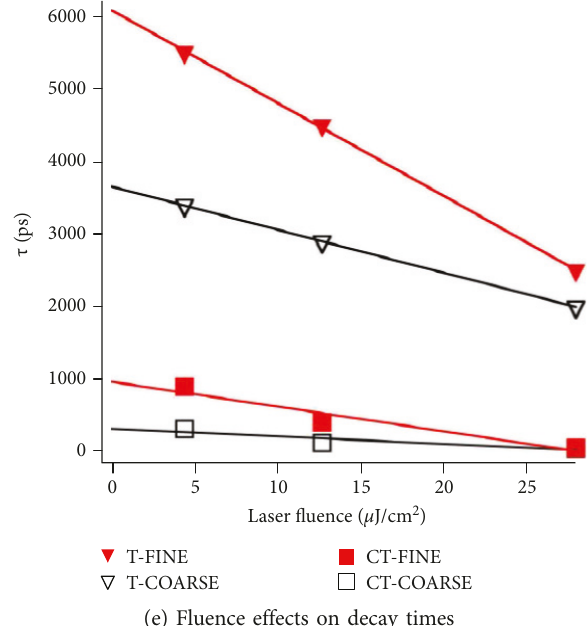
Figure 5: fs-TA data analysis of the blend fi lms. (a) Representative target model used for the analysis. Note the multiple branching pathways. The transition from A to E is singlet fi ssion. See below for key. (b) Representative concentration pro fi les of the species-associated di ff erence spectra (SADS) obtained for the FINE sample (cosolvent is ODCB) using a laser fl uence of 12 μ J/cm 2 . Decay times (in ps) belongingto the various species are 0.29 (FC), 2.86 ( ∗ S1), 40 ( ∗ CT), 410 (CT), and 4.5ns (T); see below for key. (c) Representative normalized SADS obtained for the FINE sample (cosolvent is ODCB) using a laser power of 28 μ J/cm 2 . Decay times (in ps) belonging to the various species are 0.39 ( ∗ S1), 5.5 ( ∗ CT), 60 (CT), and 2.5ns (T). FC species is not shown. (d) Relative triplet and charge transfer state formation e ffi ciency as functions of laser fl uence for the COARSE and the FINE blend fi lms, with 2nd-order polynomial fi t. (e) Change of triplet and charge transfer excited state lifetimes as function of laser fl uence for the COARSE and the FINE blend fi lms, with linear fi t. Key: Franck-Condon (FC) state = black, hot S transfer state ( ∗ CT)=red, charge transfer state (CT)=blue, triplet (T)=green. It has to be noted that the hot CT state is not a vibrational hot CT state but a collection of higher lying CT states within the CT density of